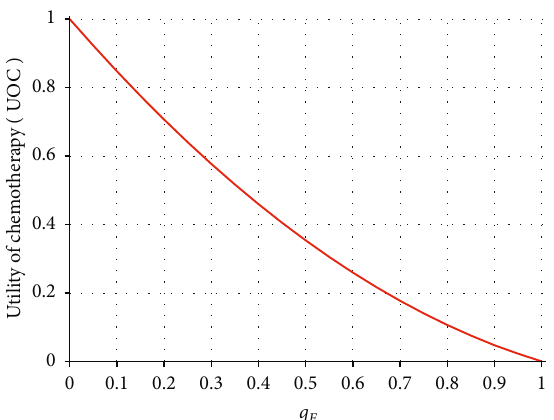
Figure 3: Utility of chemotherapy (UOC) for the chemotherapy-induced death coefficient of effector cell ( q